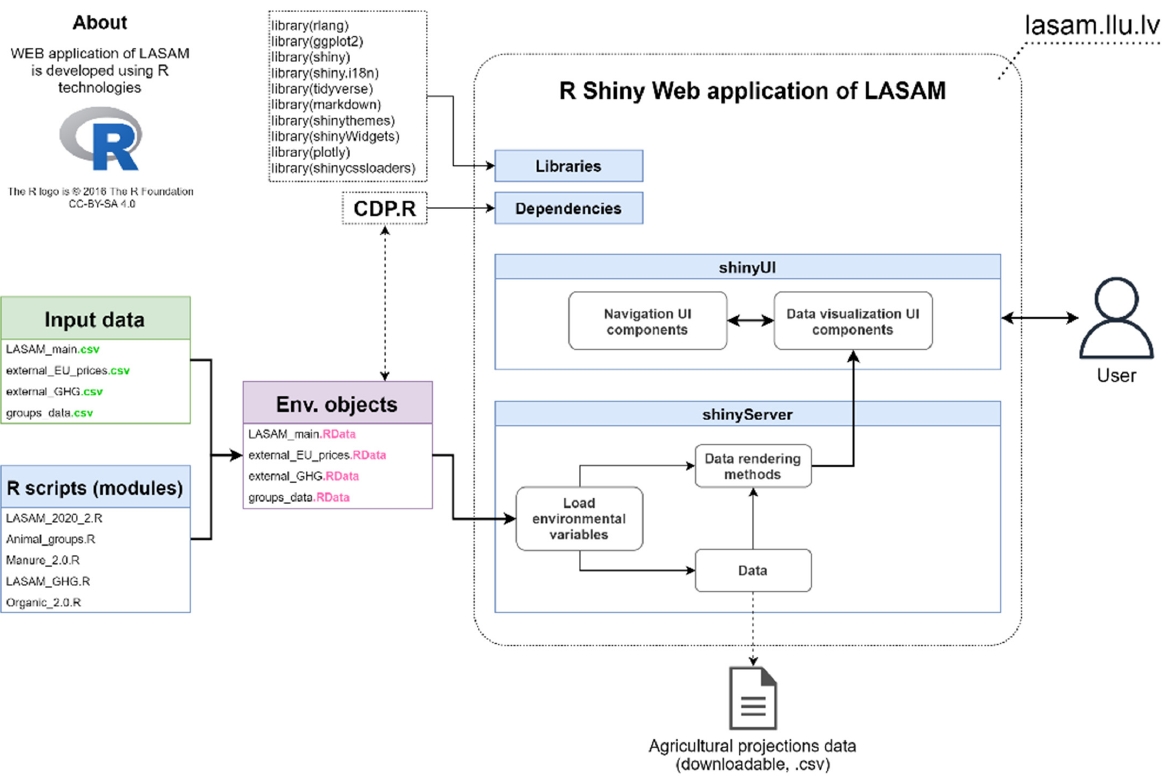
Figure 2. Architecture of the interactive WEB application of the LASAM model.